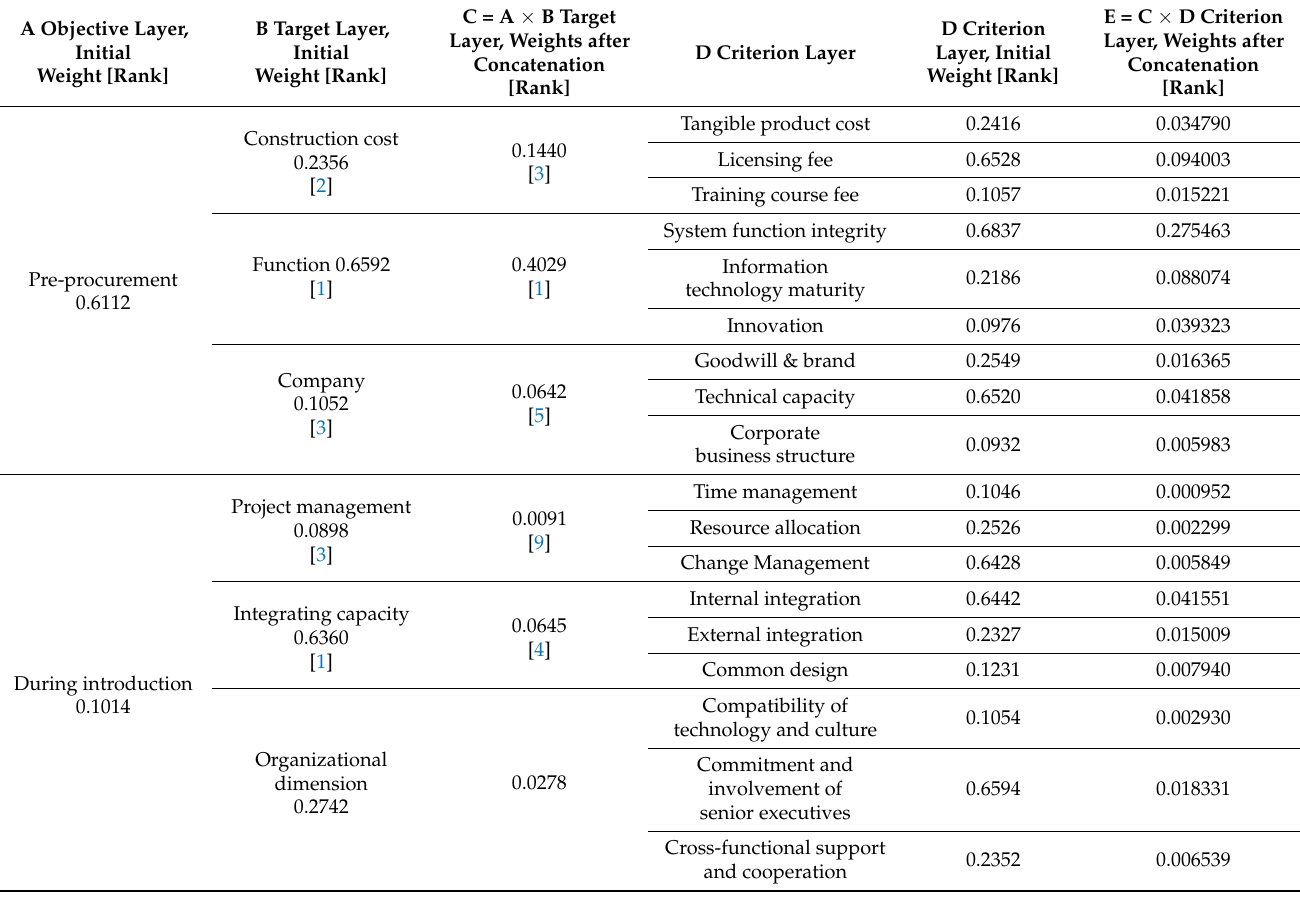
Table 4. Weights of factors influencing companies to introduce business intelligence.